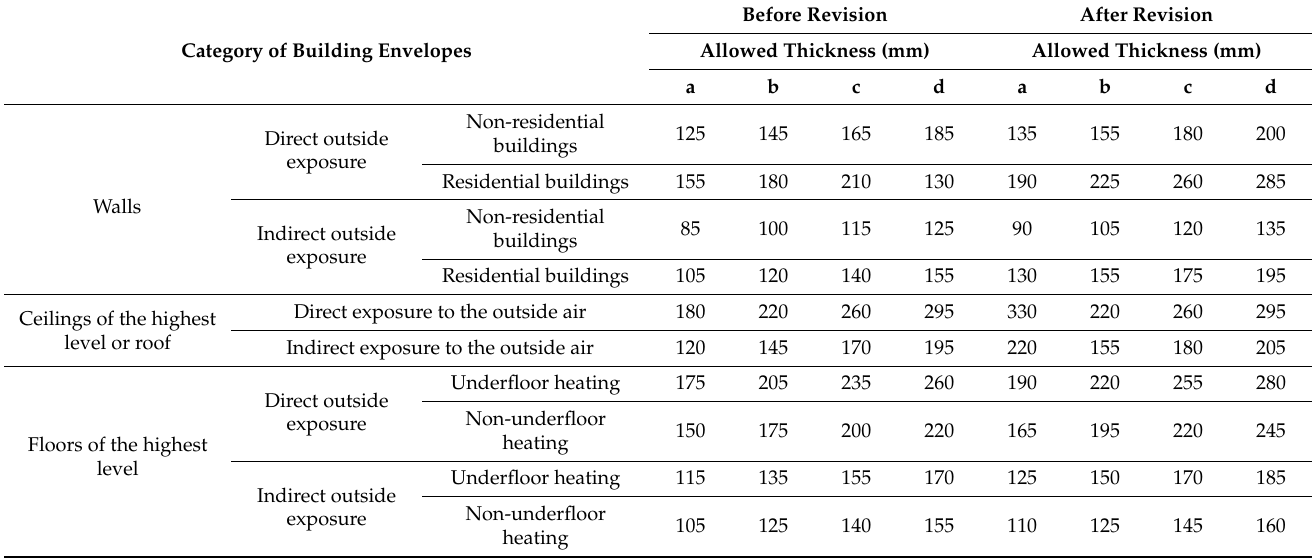
Table 1. 2017 revision of the building insulation thickness standard for the central region buildings.